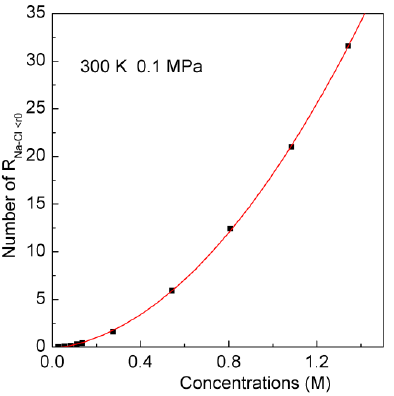
Figure 4. The number of g Na-Cl(r) less than the first minimum (3.5 Å) in various NaCl solutions. The fitted line is shown in solid.